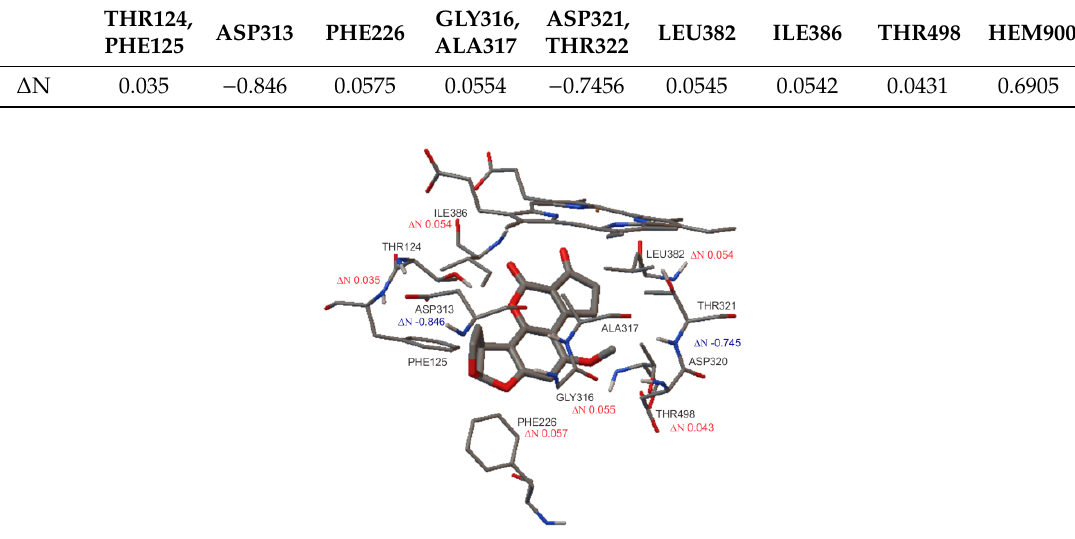
Figure 7. Schematization of transferred electron values ( ∆ N) calculated for the interactions between AFB1 and CYP1A2 protein. Red values indicate electron donors, while blue values indicate electron acceptors.